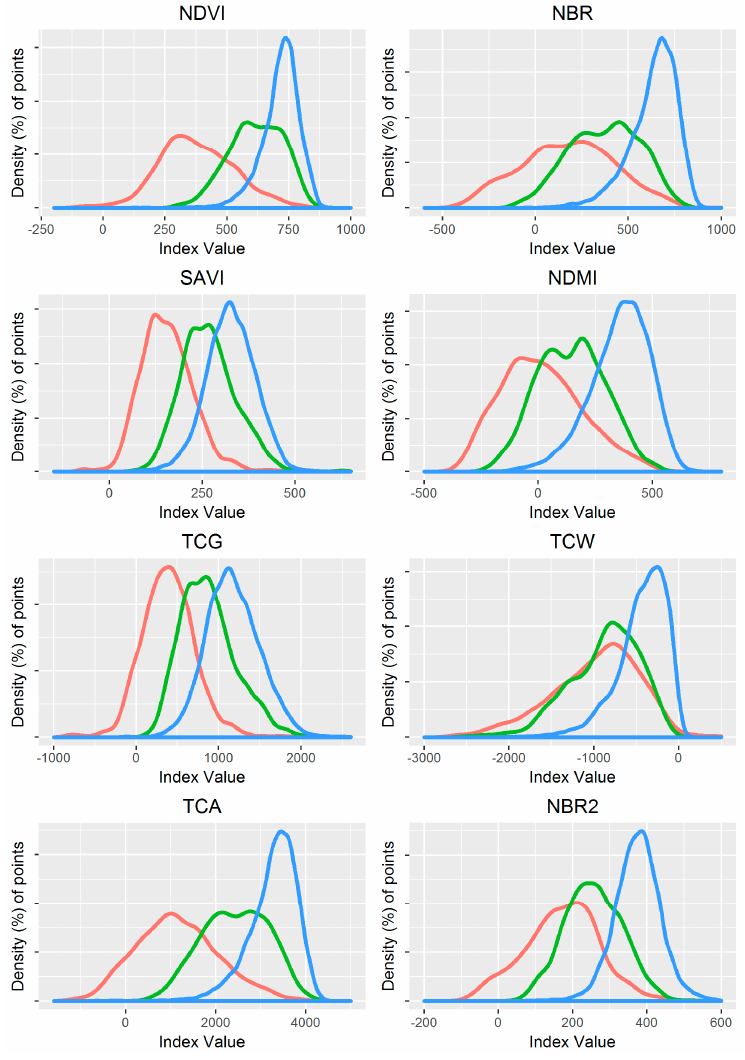
Figure 3. Density histograms showing the distributions of pre-fire values (blue), directly after fire (red), and one year post-fire (green).